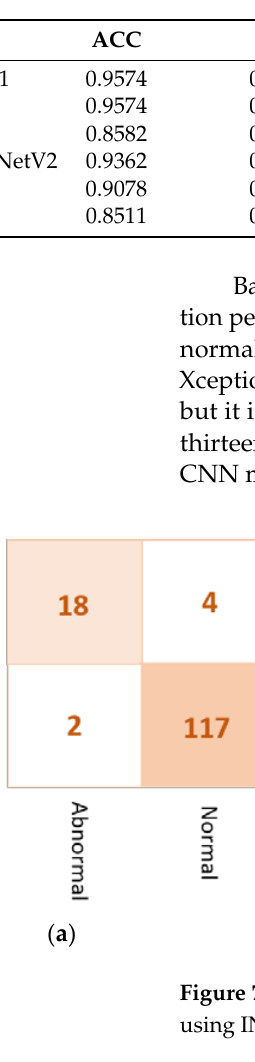
( b ) Figure 8. Evaluation performance in terms of the confusion matrices of the proposed AI models. ( a ) Ensemble learning as a backbone model and ( b ) the proposed AI-based ETECADx model.